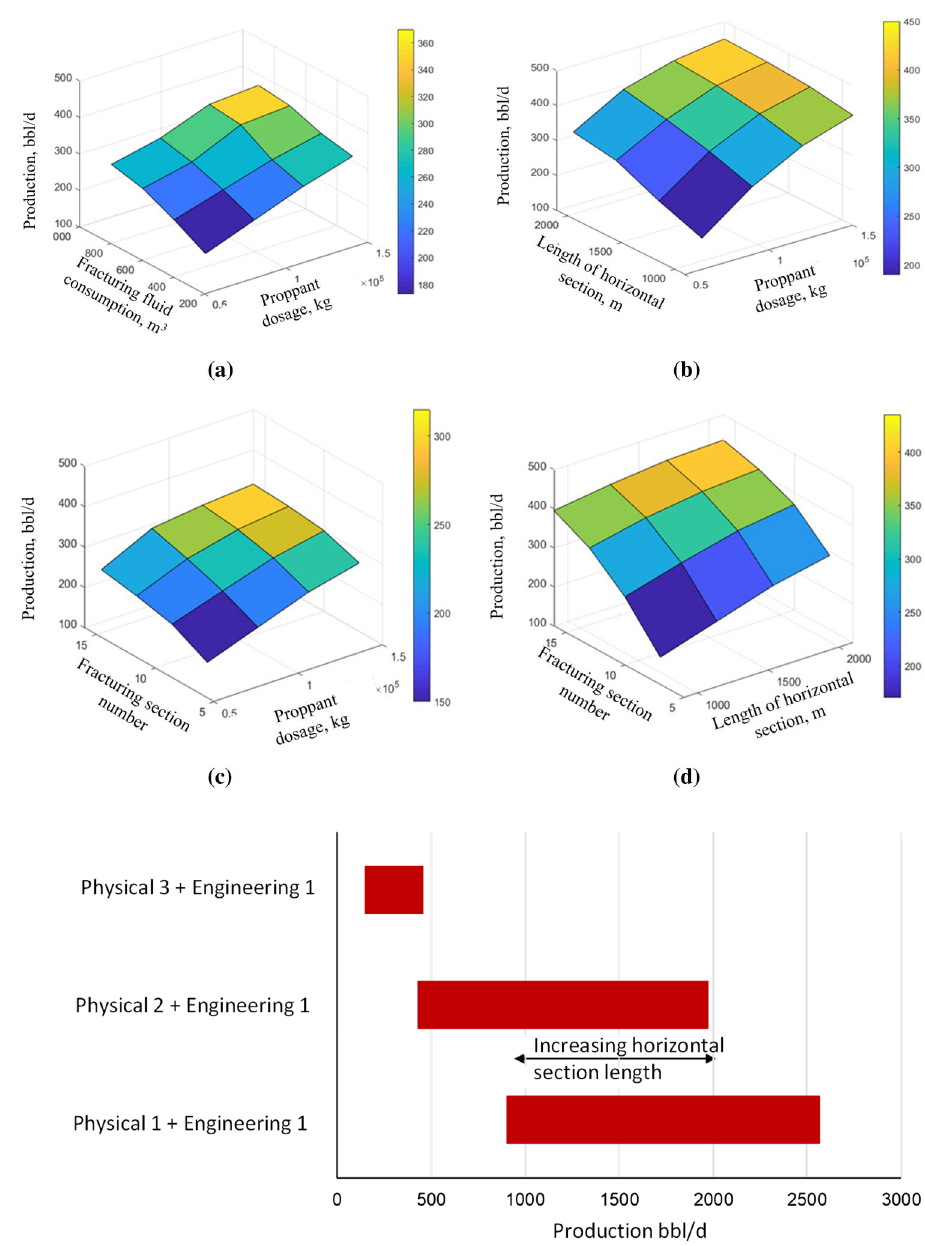
Fig. 25 Production capacity chart under various influencing factors